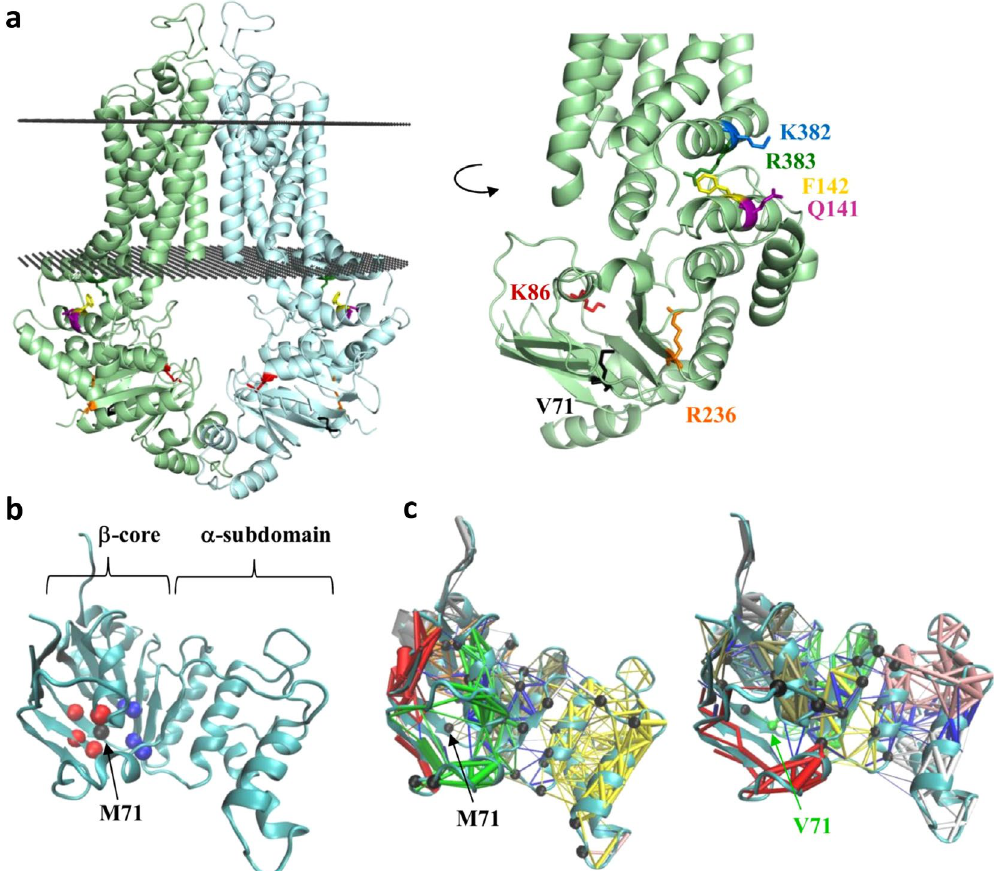
Figure 4. Location of the mutations in the ABCG2 structure – analysis of molecular dynamics. (Panel a) Left side: model of the ABCG2 dimer in the membrane. Membrane insertion of the ABCG2 structure was determined by the OPM server. Right side: NBD and NBD/TMD interfaces are magnified and selected positions for mutations are highlighted. Black dots: bilayer boundaries; green and cyan: ABCG2 protomers. (Panel b) The most frequent interactions of M71 throughout MD simulation trajectories are highlighted. Black: M71; blue: residues, the interaction of which did not change in M71V as compared to Wt; red: residues exhibiting increased interactions with M71 in the mutant as compared to the Wt. (Panel c) Dynamic communities of residues determined by the analysis of a network, generated on the basis of the correlation of motions, are labeled with different colors. Black spheres represent critical links between